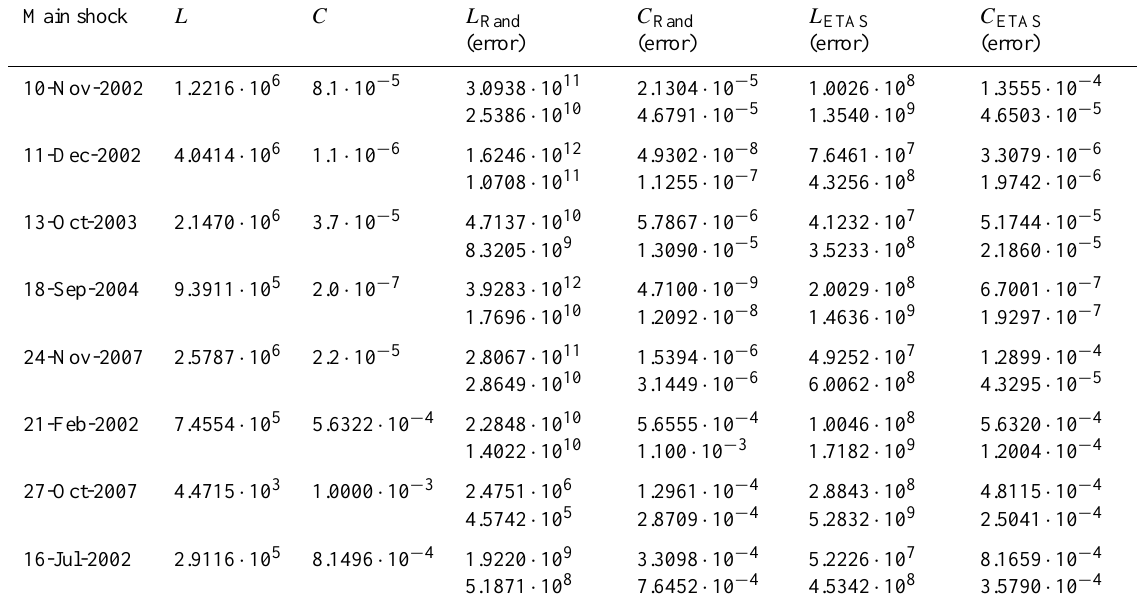
Table 4. Values of the network characteristics corresponding to the main clusters in the catalogue. L is the average path length, and C is the clustering coefficient. For the random model and the ETAS model we also provide the error bounds, below the mean value. Main shock L C L Rand